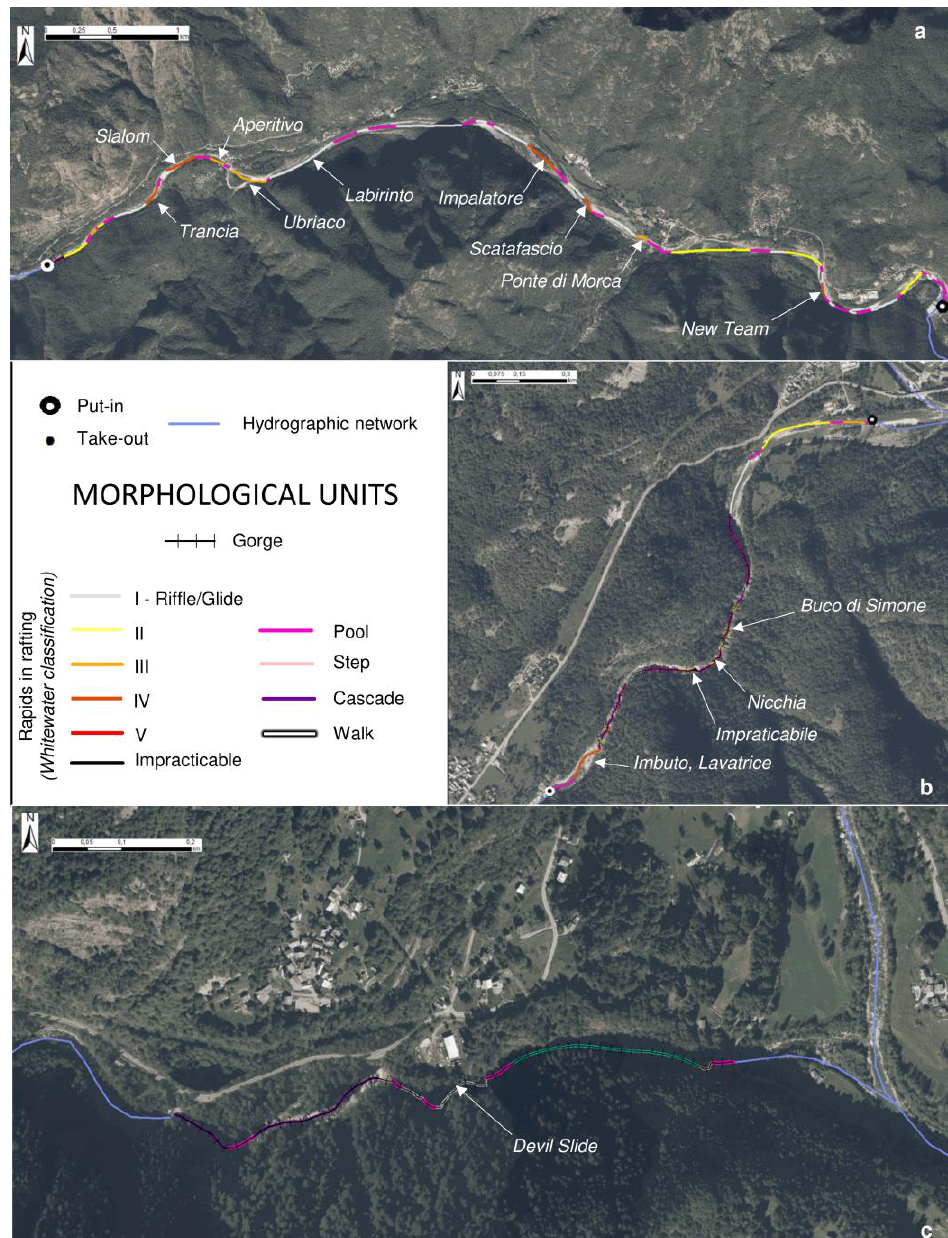
Figure 8. The morphological unit distribution along the investigated segments of Gole del Sesia (( a ) — GS), Classico del Sesia (( b ) — CS), and Canyoning Sorba (( c ) — CNS) with the Whitewater classification of rapids along Sesia river. The gorge reaches are also indicated with a specific symbol. (Background: aerial photograph © AGEA 2018). The location of traits within the UGGp is reported in Figure 2.